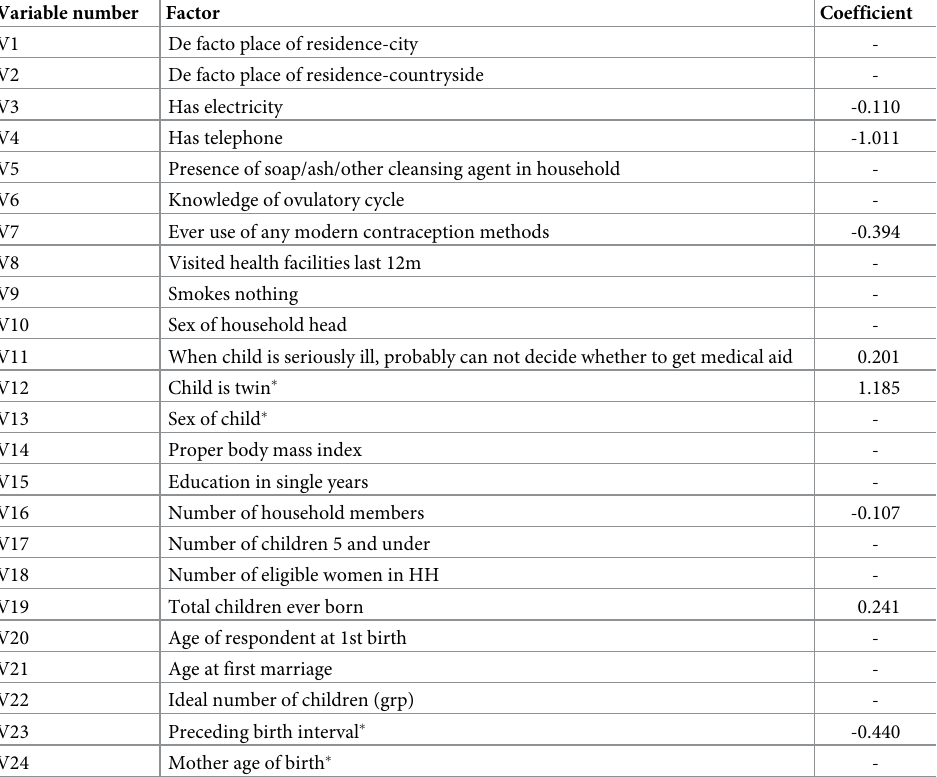
Table 8. Variables that possibly affect child mortality with six chosen by proposed sparse estimation method.